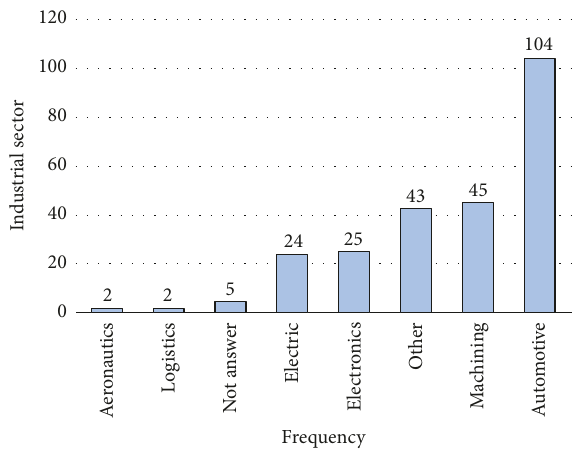
Figure 2: Surveyed industrial